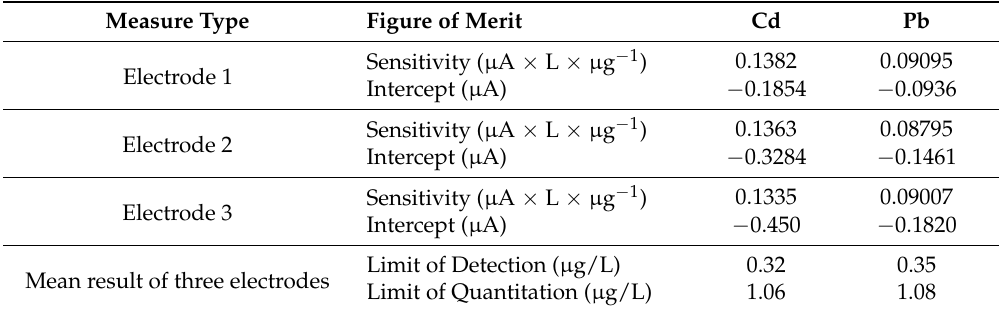
Table 3. Reproducibility and figures of merit of Cd and Pb analysis under flow-injection analysis differential pulse stripping voltammetry.